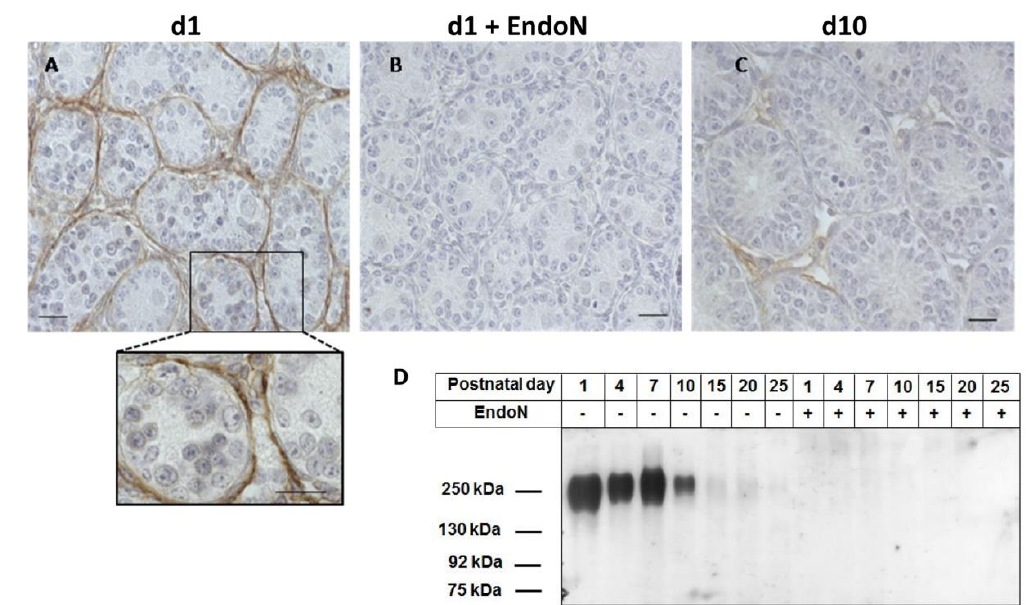
Figure 1. Visualization of polySia in postnatal testis of wild-type mice. ( A – C ) For the immunohistochemical localization of polySia in postnatal testis of 1- and 10-day-old mice, tissue sections were treated with a mAb against polySia. All scale bars: 20 µ m. ( B ) For negative control, the tissue samples were pretreated with endoN to degrade polySia. The sections were counterstained with hematoxylin. ( D ) In addition, protein lysates were separated by SDS-PAGE (0.3 µ g protein/lane) for Western blotting. The immunostaining was performed with an anti-polySia mAb. Samples treated with endoN were used as negative controls.